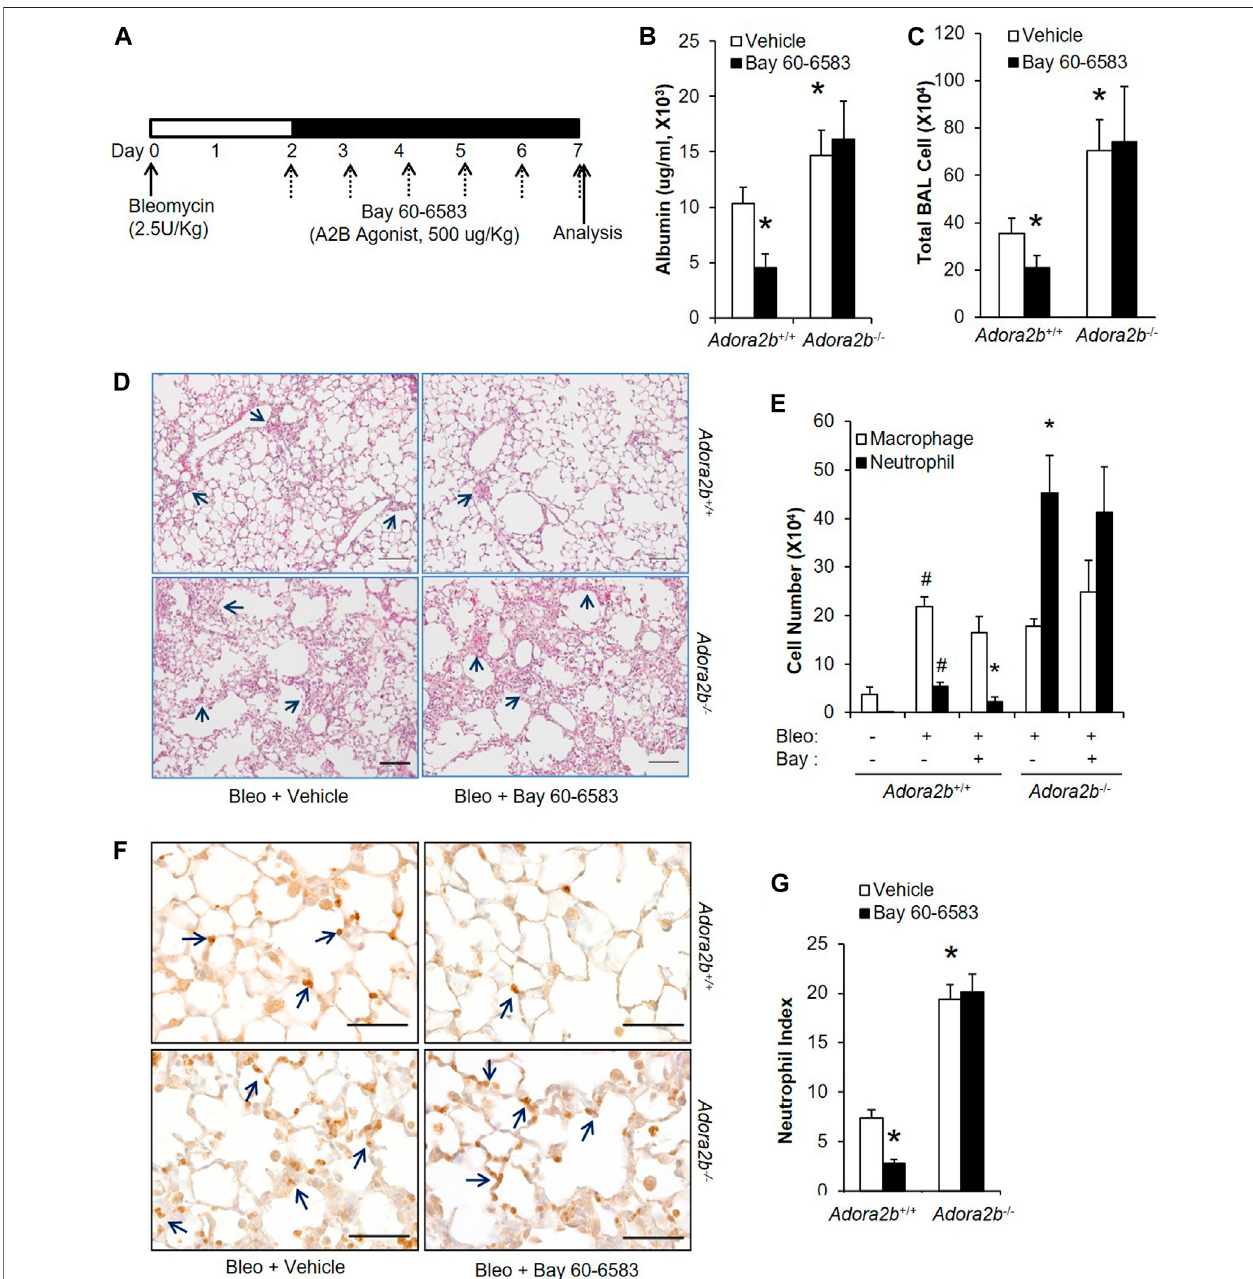
FIGURE5| TherapeuticeffectofBAY60-6583onestablished ALIin Adora2b+/+ and Adora2b − / − mice. (A) Adiagramshowinghow Adora2b+/+ and Adora2b − / − mice were treated with BAY 60-6583 and bleomycin. (B) BAL albumin levels were measured to show the levels of vascular leakage. (C) BAL total cell number was counted. (D) RepresentativeH&Estainingsoflungsfrom bleomycin and/or dipyridamole treatedmice.Arrows pointing areaswithin fl ammation.Scale bar (cid:2) 500 µM. (E) Differentialassaywasperformedtodeterminethenumber ofmacrophageand neutrophilinthelungs. (F) Mouselungsections fromdifferenttreatmentgroupwere stained with anti-Ly6B.2 to visualize neutrophil expression and localization. Arrow: positive stained neutrophils. Scale bar (cid:2) 100 µM. (G) The number of neutrophil for each treatment group was quantitated. N (cid:2) 5, * p < 0.05 vs. wildtype bleomycin vehicle. # p < 0.05 vs. wild type PBS using one way ANOVA followed by Bonferroni ’ s multiple comparisons